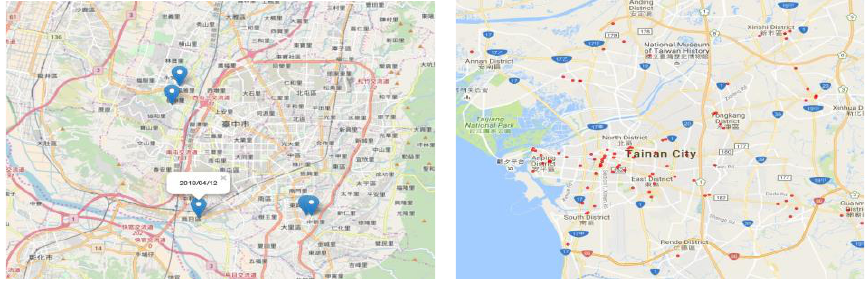
Fig. 2. Data visualization by Python and